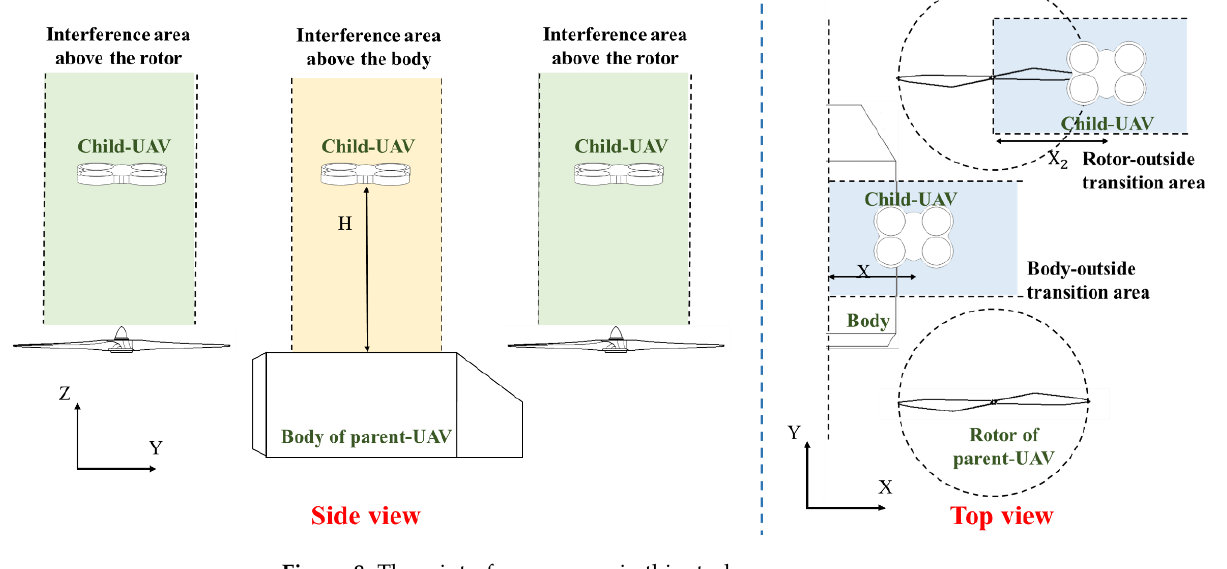
Figure 8. Three interference areas in this study.